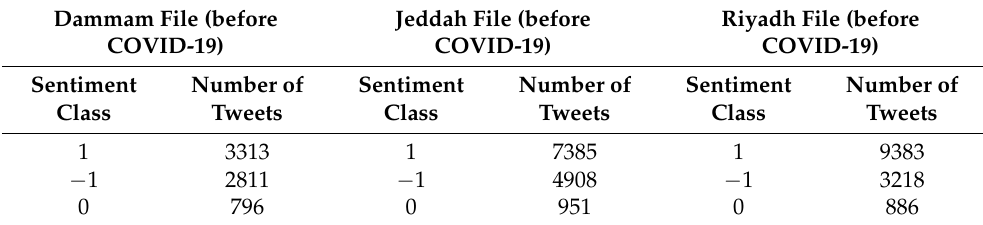
Table 11. Distribution of sentiment classes of (during COVID-19) dataset.